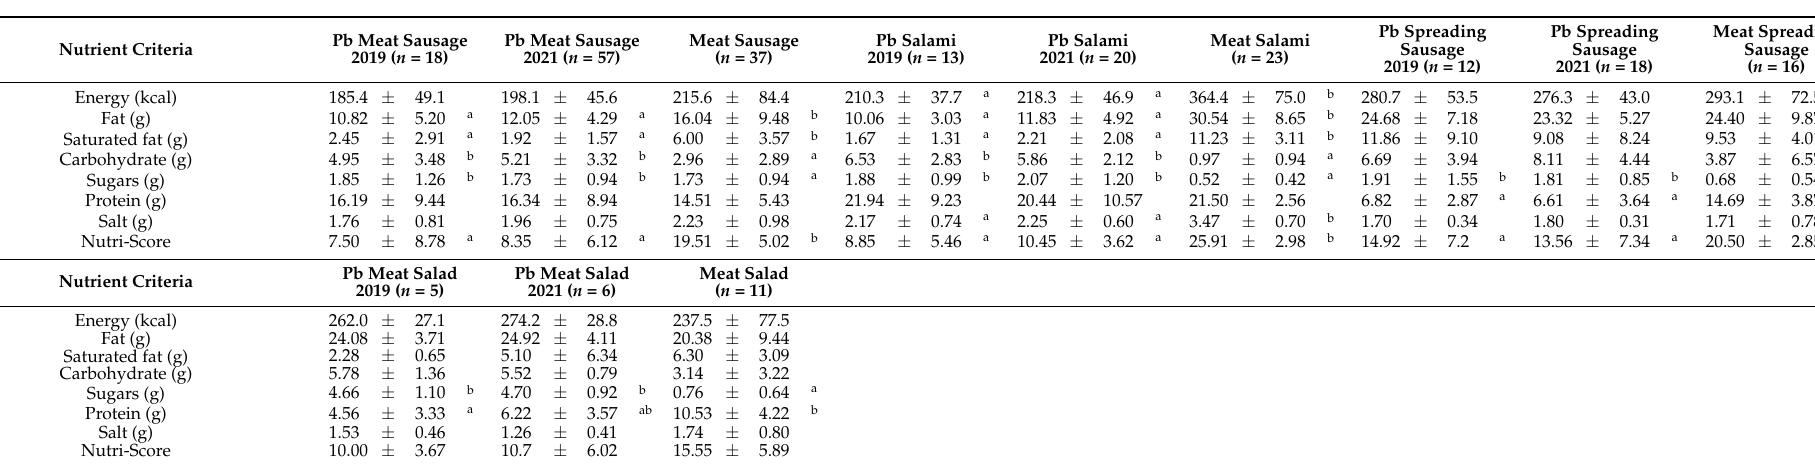
Table 5. Nutrients (“Big 7”) and Nutri-Score per 100 g of pb meat cold cuts alternatives and cold cuts meat (mean and standard deviation) in four different food groups, compared to animal-based products